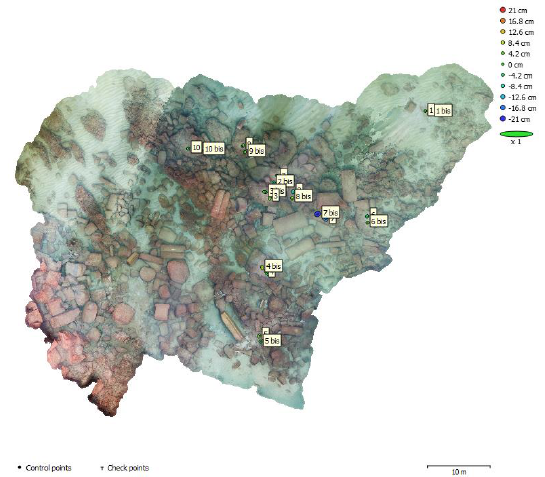
Figure 13. Integrated GCPs in 2016 for the two seasons 2014 and 2015 (Mohamed Abdelaziz)